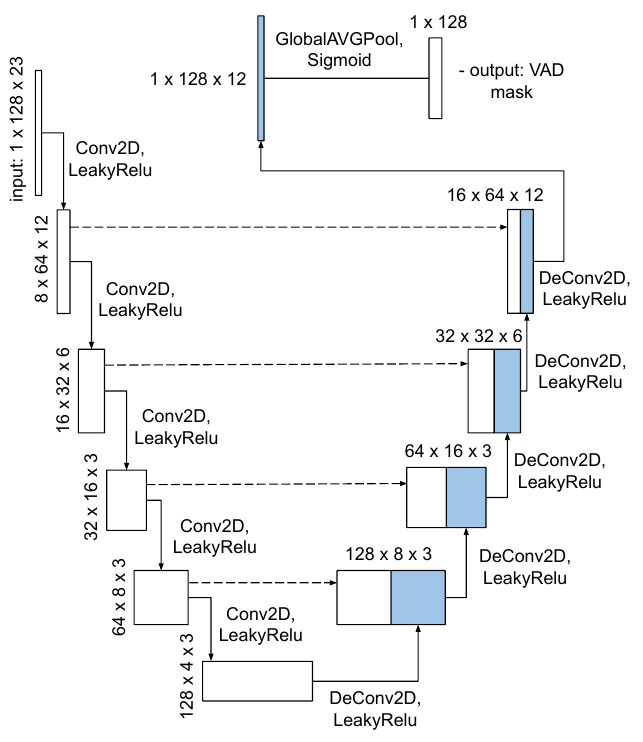
Figure 1. The applied U-Net VAD model